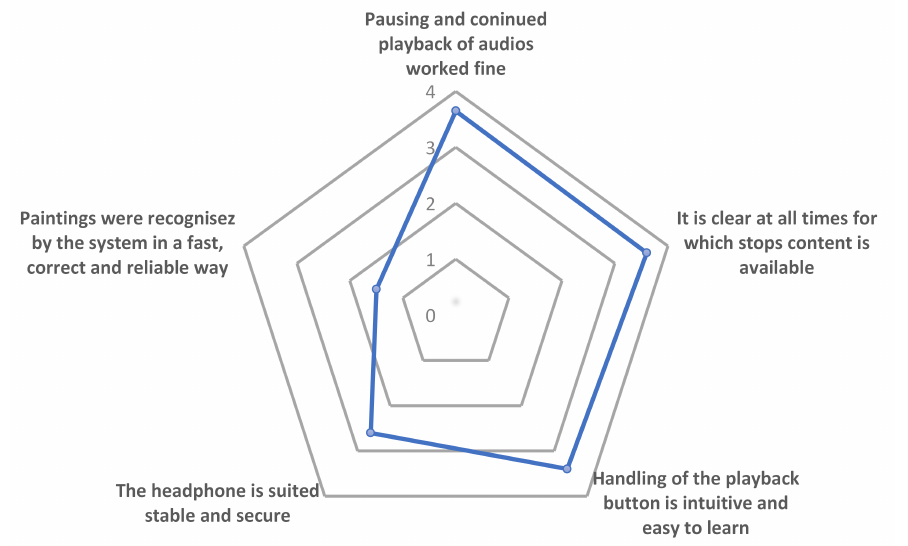
Figure 17. Assessment of user experience to the question. How do you rate the handling of the tested